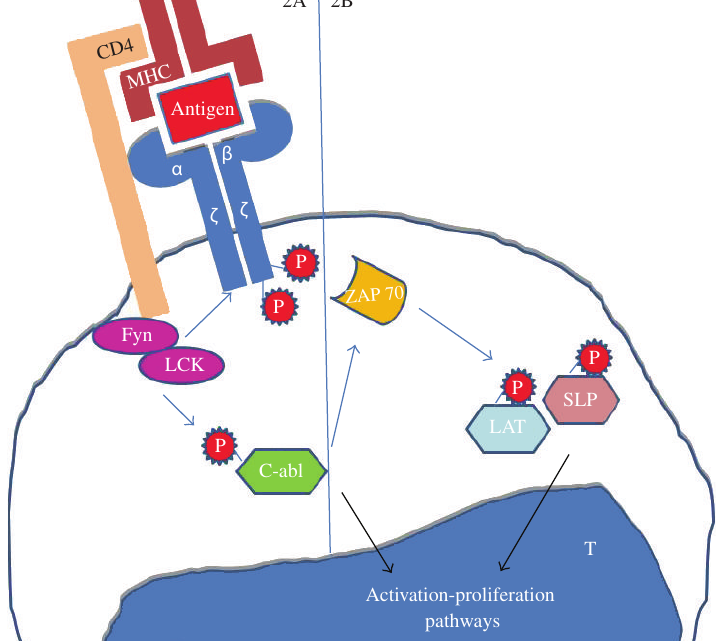
FIGURE 2: (A) After linking between TCR and MHC-peptide and after coreceptor CD4 engagement, LCK and Fyn kinases are activated. LCK and Fyn in turn phosphorylate TCR complex and c-ABL. (B) ZAP- 70 links phosphorylated TCR and is phosphorylated itself by c-abl. So ZAP-70 can phosphorylate other downstream kinases (SLP-76, LAT) to permit T-cell activation and proliferation. P: phosphate; MHC: major histocompatibility complex; T: T-lymphocyte